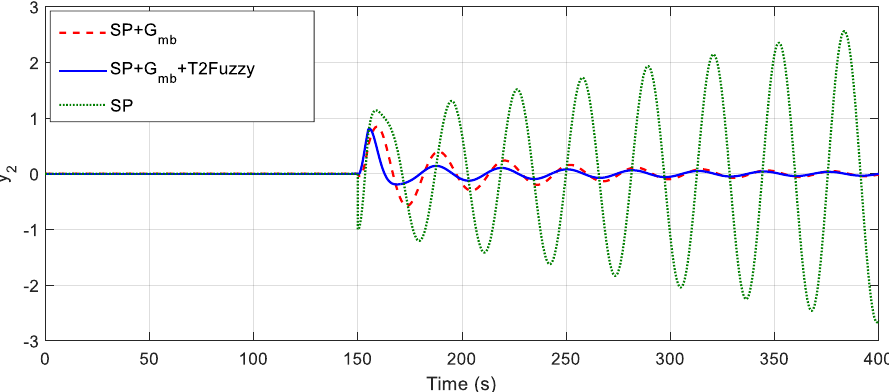
Figure 16. Performance of three control methods for 𝑦 2 by applying uncertainty.